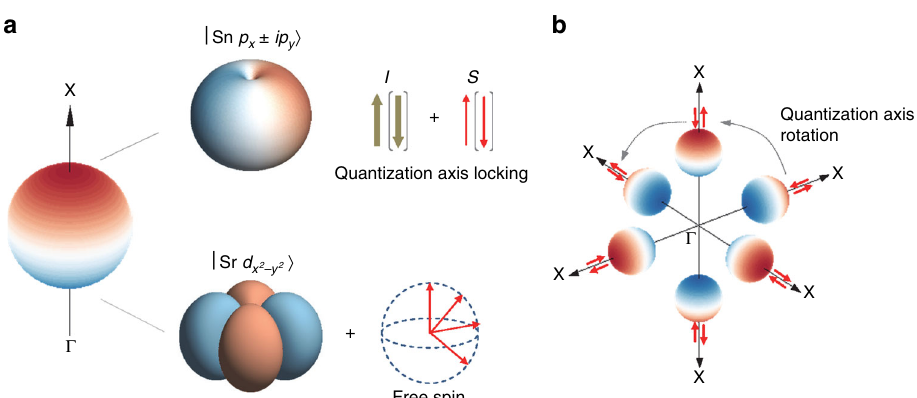
Fig. 7 Orbital and spin character contributing to the Dirac pockets. a Magni fi ed view of one of the Dirac pockets. The principal axis of the orbital is locked parallel to momentum for both the north and south poles. In addition, strong spin – orbit interaction locks the spin-quantization axis at the north pole. b Intervalley scattering under strong locking of the spin-quantization axis and momentum. Rotation of the spin-quantization axis is expected for scattering between north pole states in Dirac pockets that lie along orthogonal Γ – X lines (dashed lines). Spin-momentum entanglement follows from such intervalley